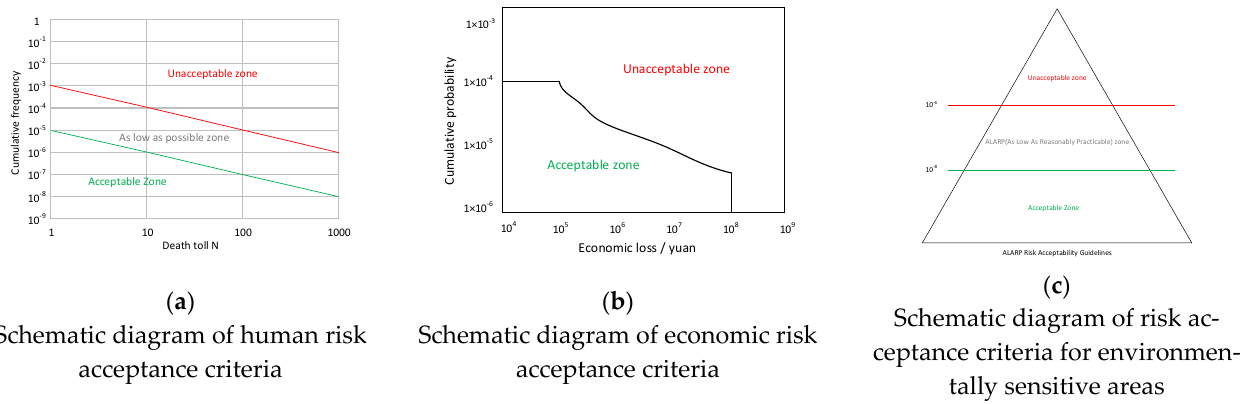
Table 14. Relevant values for indicator calculation.